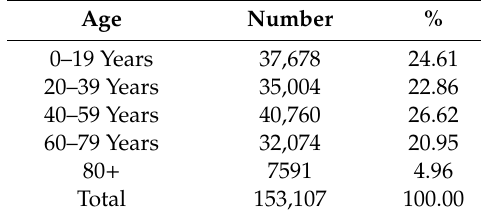
Table 4. The breakdown of the population of City of Greater